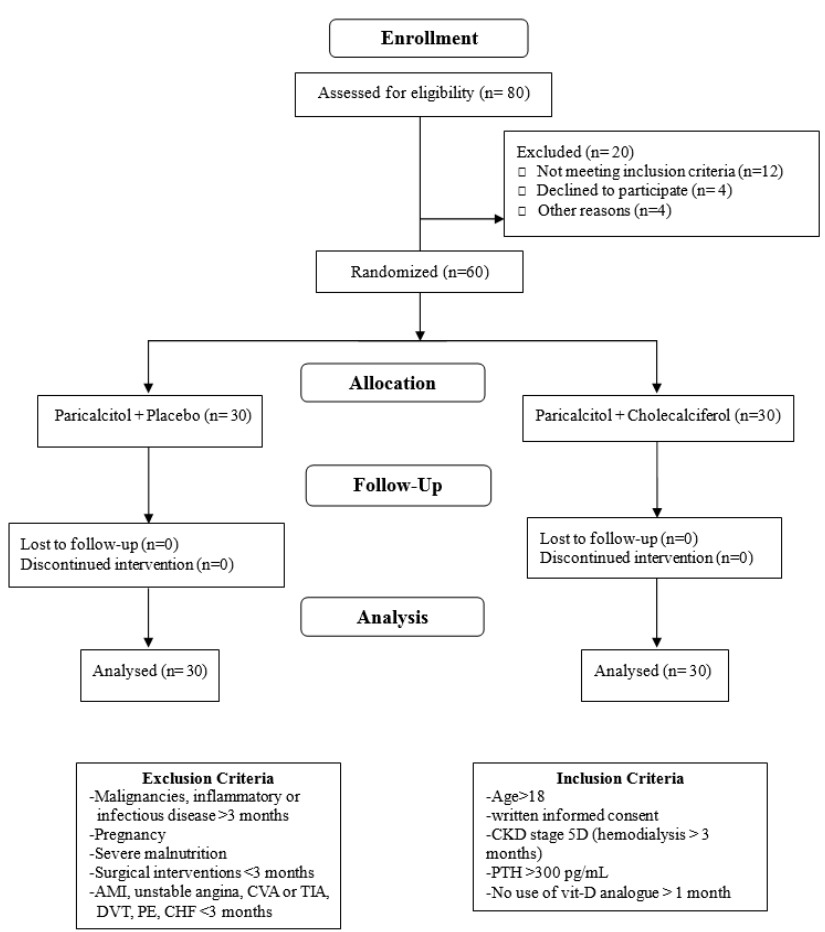
Figure 1. Study participants’ flow chart. AMI: acute myocardial infarction; CVA: cerebrovascular accident; TIA: transient ischemic attack; DVT: deep vein thrombosis; PE: pulmonary embolism; CHF: congestive heart failure; CKD: chronic kidney disease; PTH: parathyroid hormone.